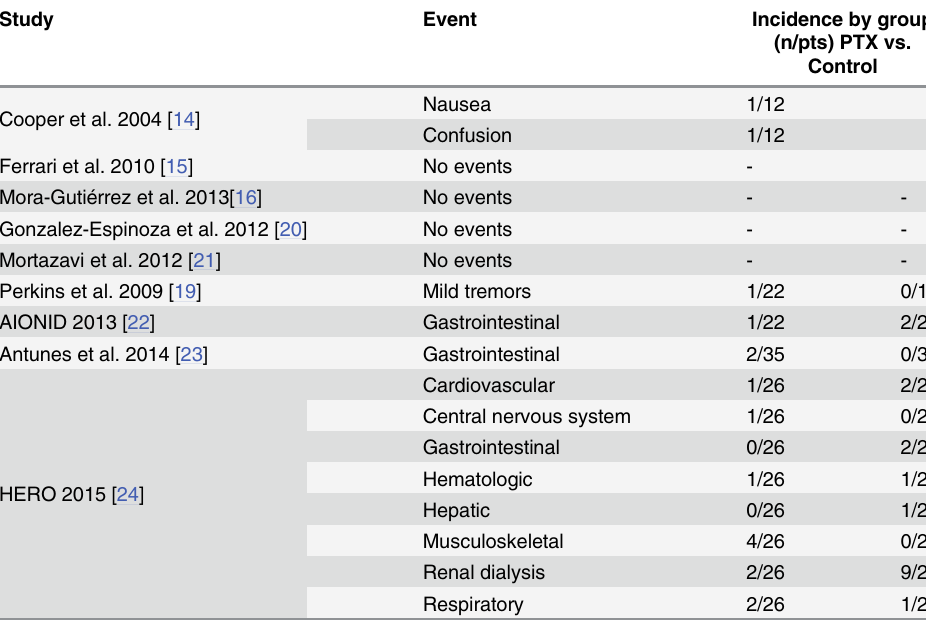
Table 3. Main adverse events recorded in the reviewed studies. Study Event Incidence by group